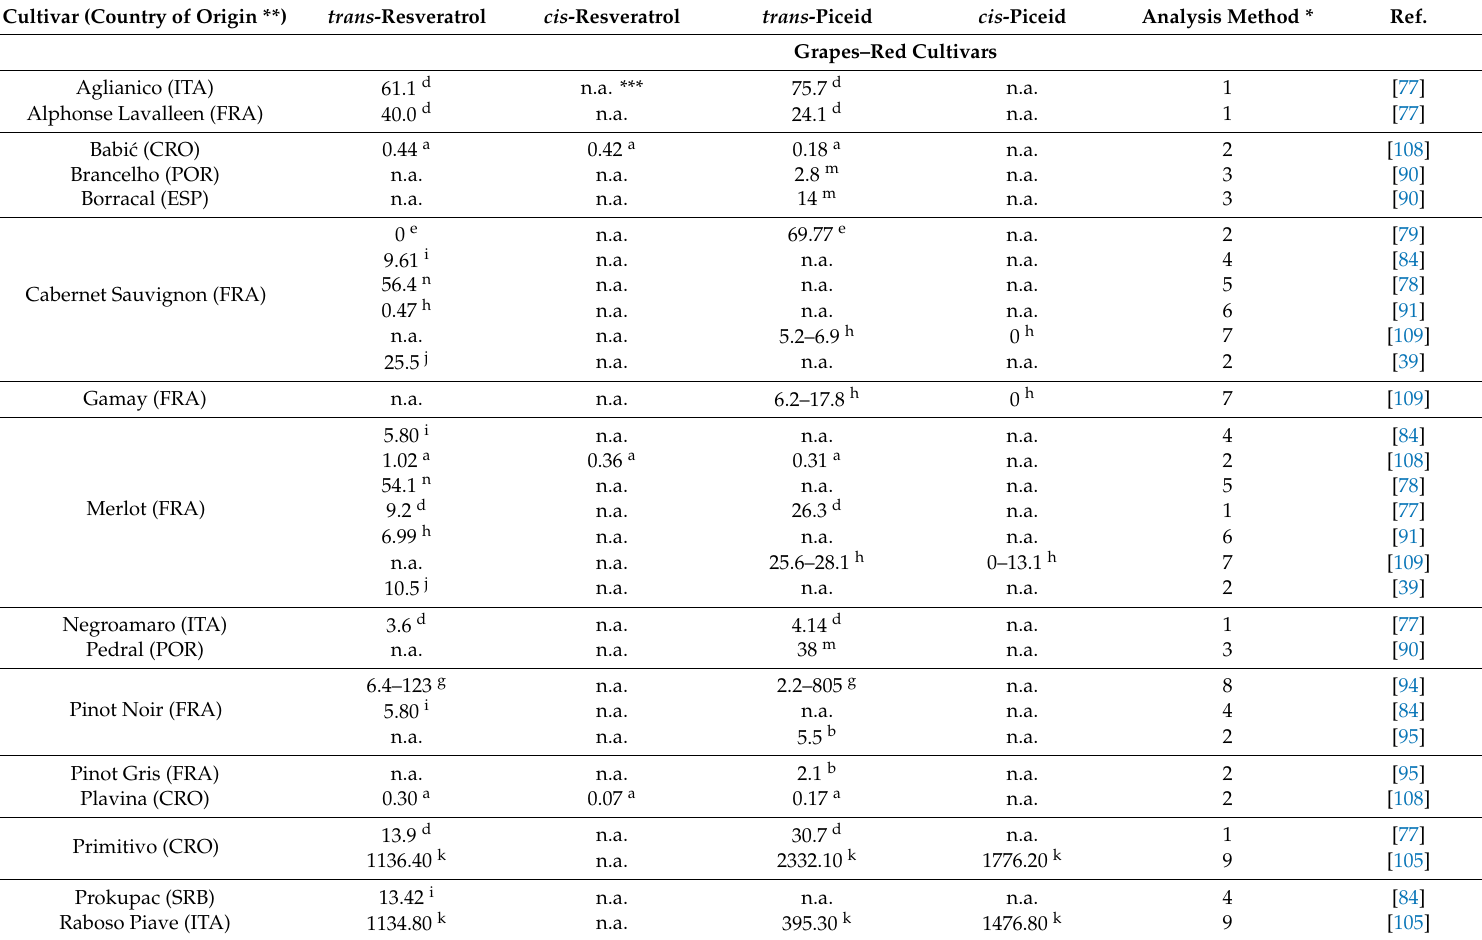
Table 3. Contents of stilbenes in grapes of di ff erent grapevine